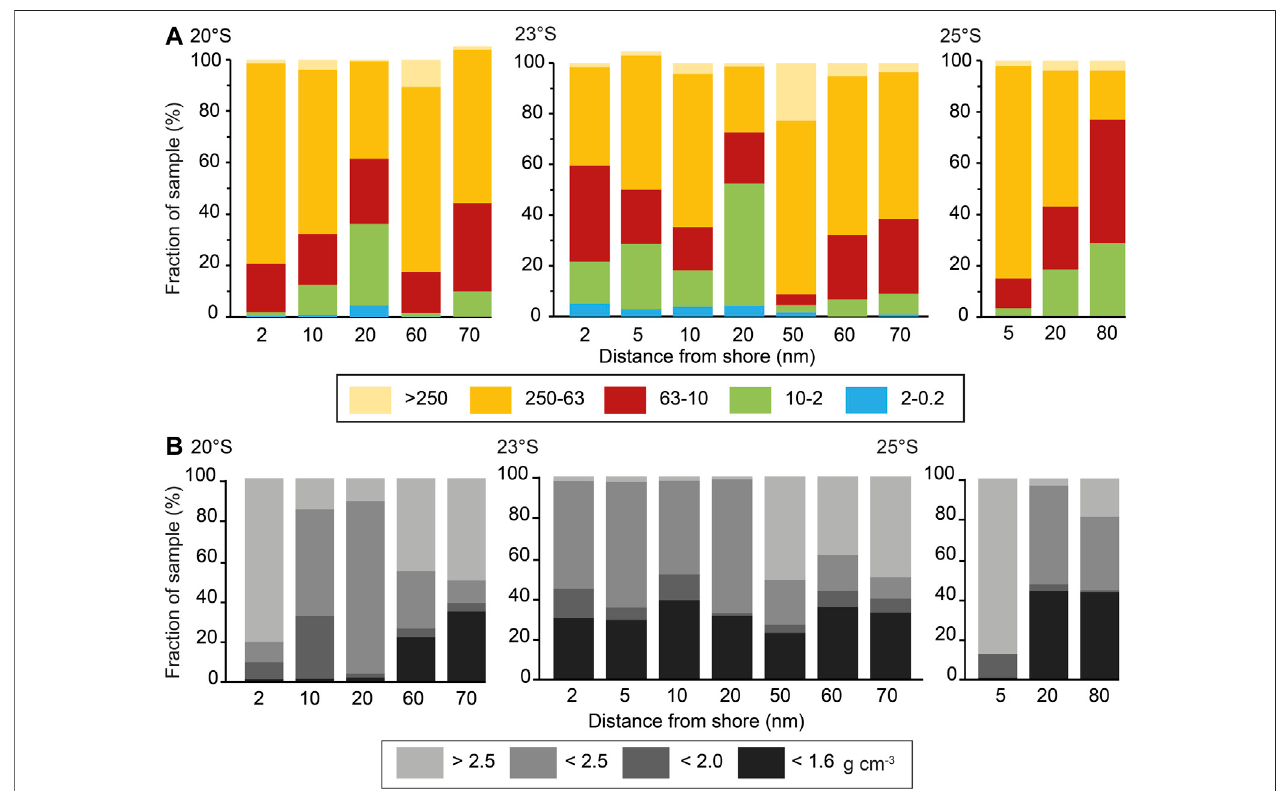
FIGURE 8 | (A) Grain size and (B) density fraction distribution on the Namibian shelf along three shore-perpendicular lines from inshore to offshore (in nautical miles), colour-coded for grain size fractions and density fractions, respectively. (A) The sediment is distributed evenly over the shelf with highest bulk sediment sizes offshore 23 ° S between 50 and 60 nm and inshore 25 ° S at 5 nm distance from shore. At the inshore and offshore depocenters (23 ° S 20 and 25 ° S 80 nm), mostly silty surface sediment is deposited. (B) Density fraction distribution of the same samples is variable, with a notable increase in low-density fractions offshore 20 ° S and 25 ° S, while 23 ° S, the lowest density fraction remains at ~40% of the total